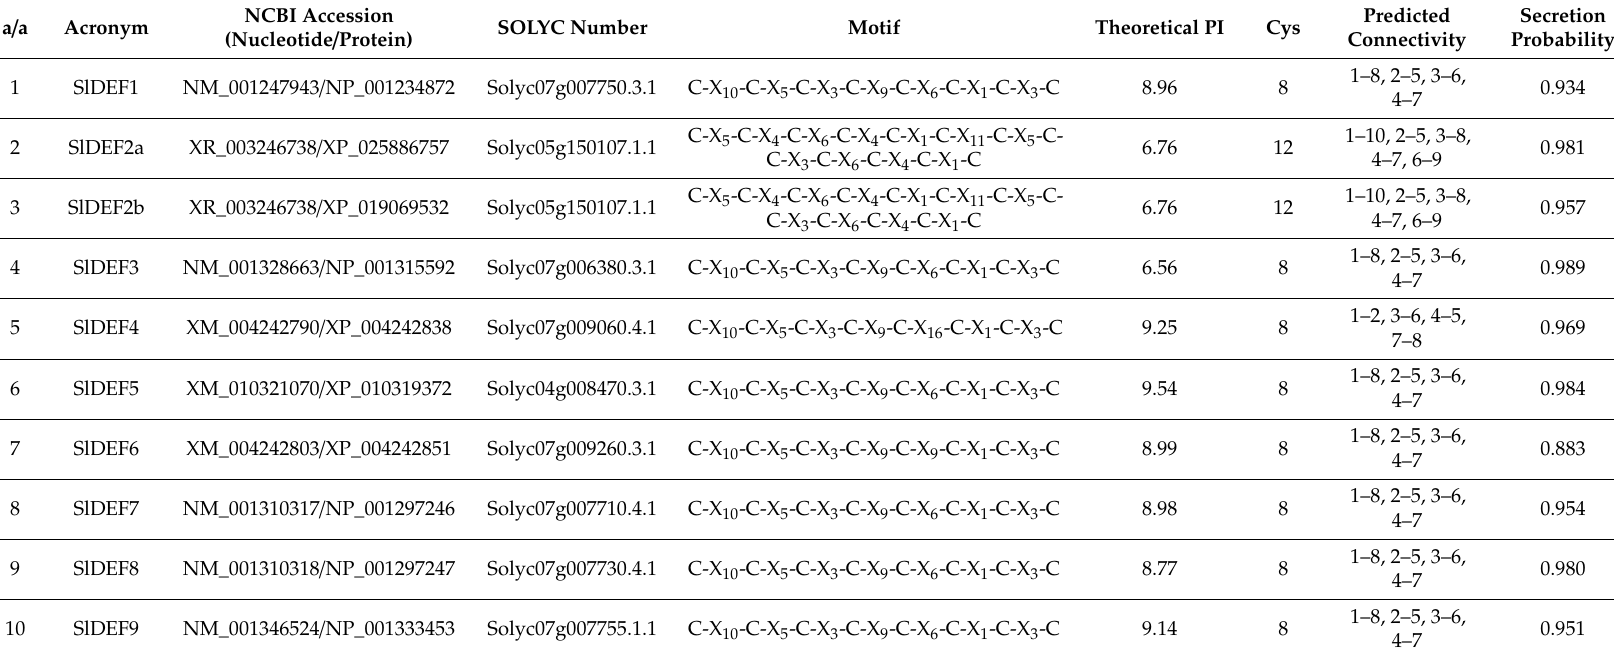
Table 1. Defensin accession numbers, protein secretion probability, and cysteine motifs /